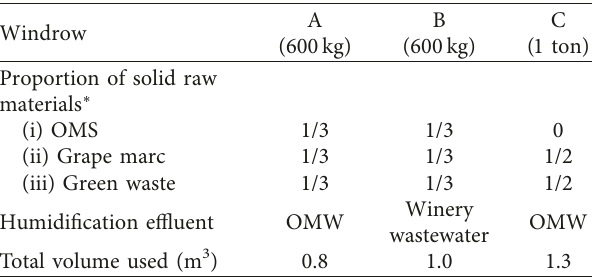
Table 2: Composition of the different windrows.